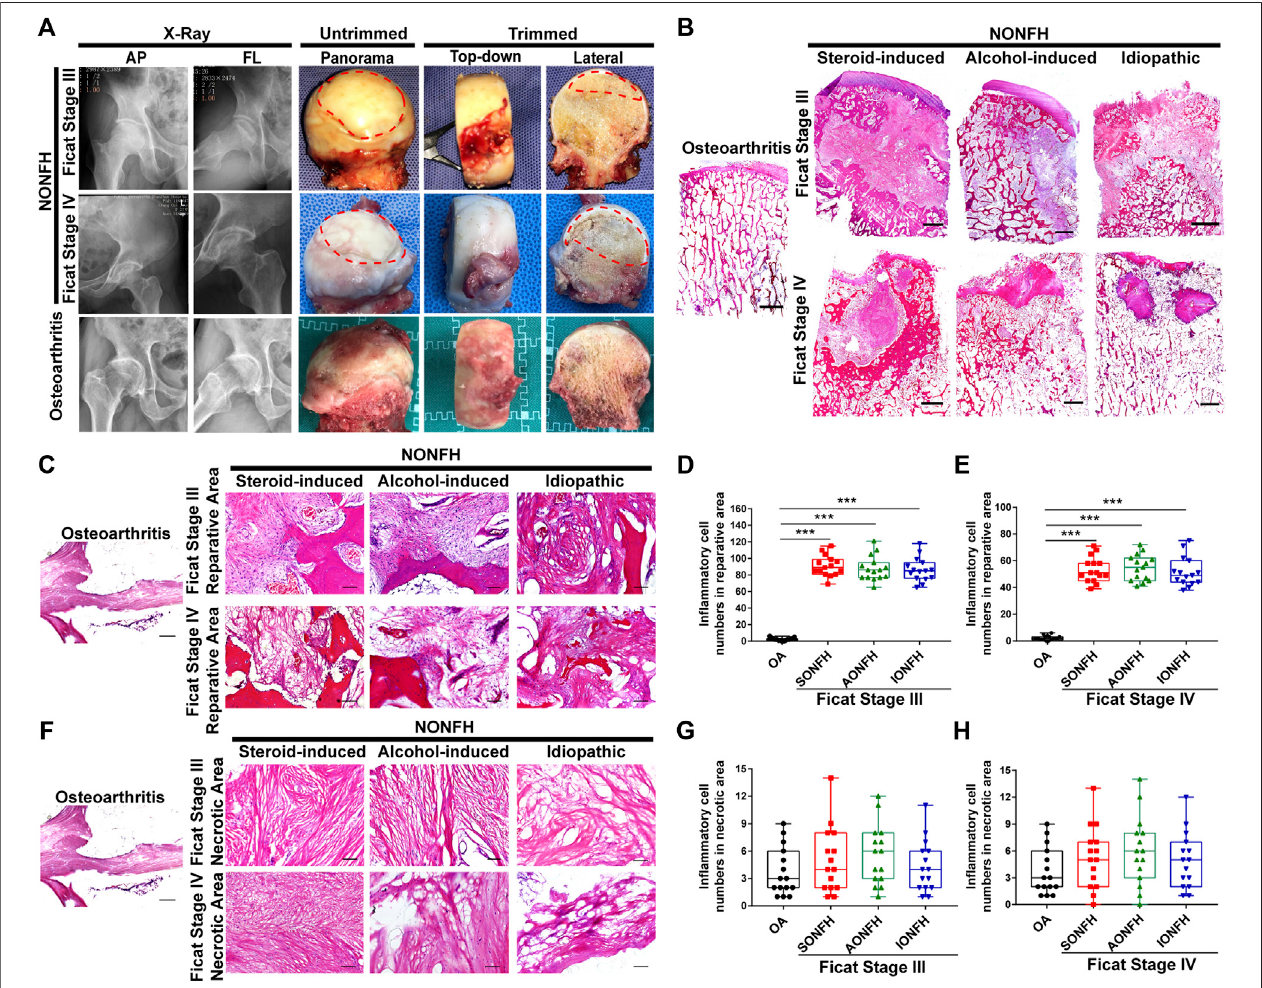
FIGURE 1 | In fl ammatory cells were enriched mainly in the reparative area sites of repair and their numbers gradually fell during progressive-stage to end-stage NONFH (A) Representative X-ray and femoral heads gross sample pictures from patients with NONFH. AP: anteroposterior, FL: frog-leg lateral (B) Representative images of HE-stained sections from patients with different types and stages of NONFH. SONFH, steroid-induced osteonecrosis of the femoral head; AONFH, alcohol- induced osteonecrosis of the femoral head; IONFH, idiopathic osteonecrosis of the femoral head. Scale bar, 2.5 mm (C – E) Representative images (C) and in fl ammatory cell quanti fi cation (D,E) in the reparative area in HE-stained tissues from patients with different types of progressive NONFH. Scale bar, 100 μ m (F – H) Representativeimages (F) andin fl ammatorycellquanti fi cation (G,H) innecroticareasofHE-stainedtissuesfrompatientswithdifferenttypesandstagesofNONFH.* p < 0.05; ** p < 0.01; *** p <